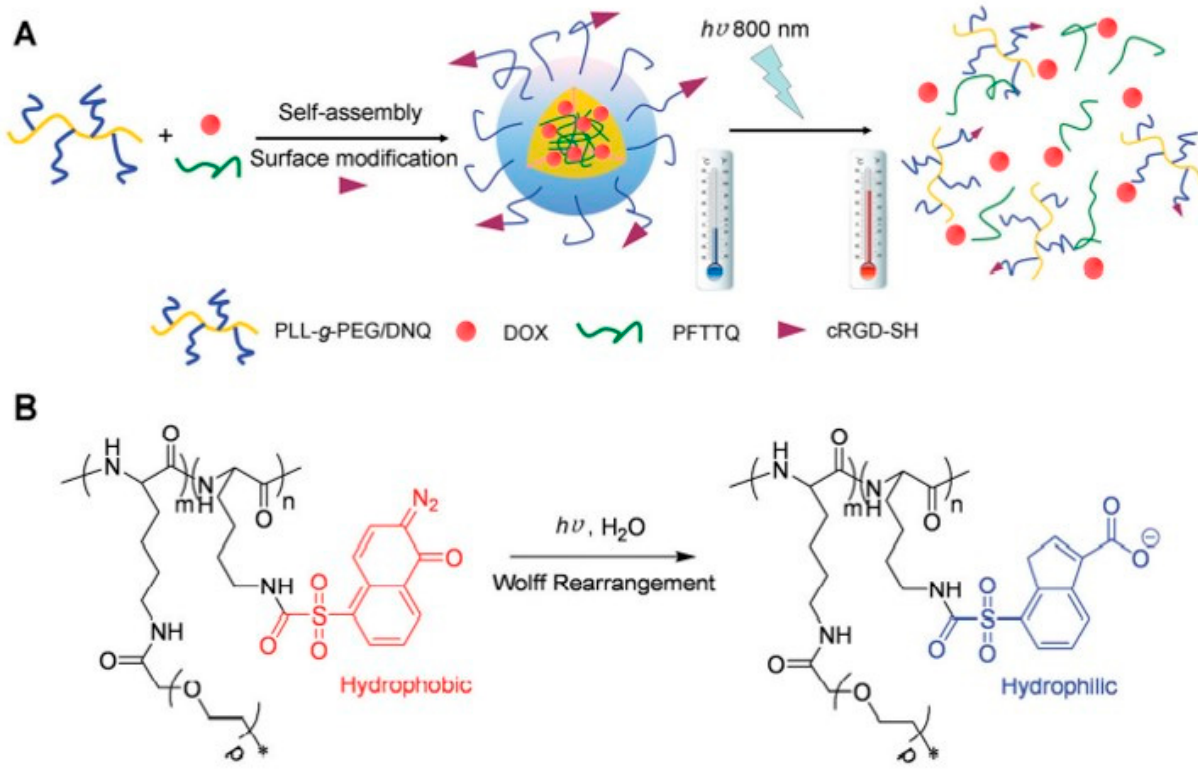
Figure 5. ( A ) Schematic illustration of preparation of PLL-g-PEG/DNQ nanoparticles and two-photon-mediated disassembly and concomitant drug release, and ( B ) chemical structure of PLL-g-PEG/DNQ and light-induced Wolff rearrangement. Adapted with permission from ref. [50] Copyright 2015 The Royal Society of Chemistry.